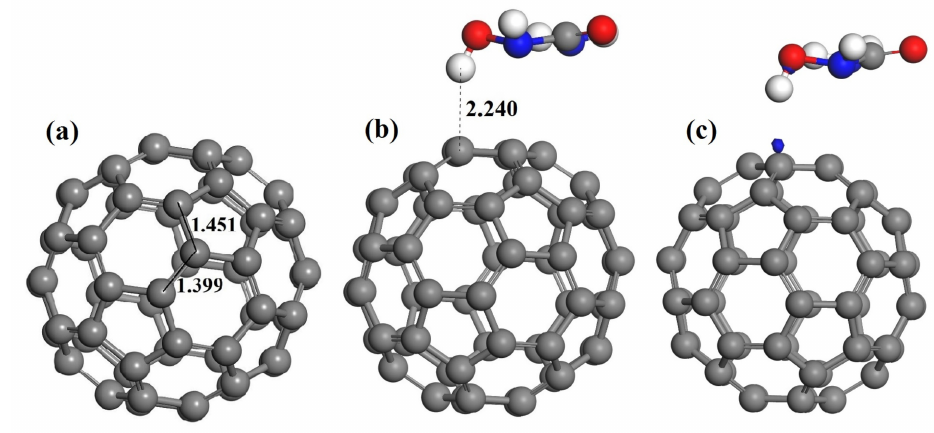
(Table 1) of the pristine C 60 and HU systems is − 0.271 eV. The relatively low adsorption energy and the almost unaltered geometric parameters of pristine C 60 and the HU indicate that the interaction between them mainly occurs via noncovalent bond [45].